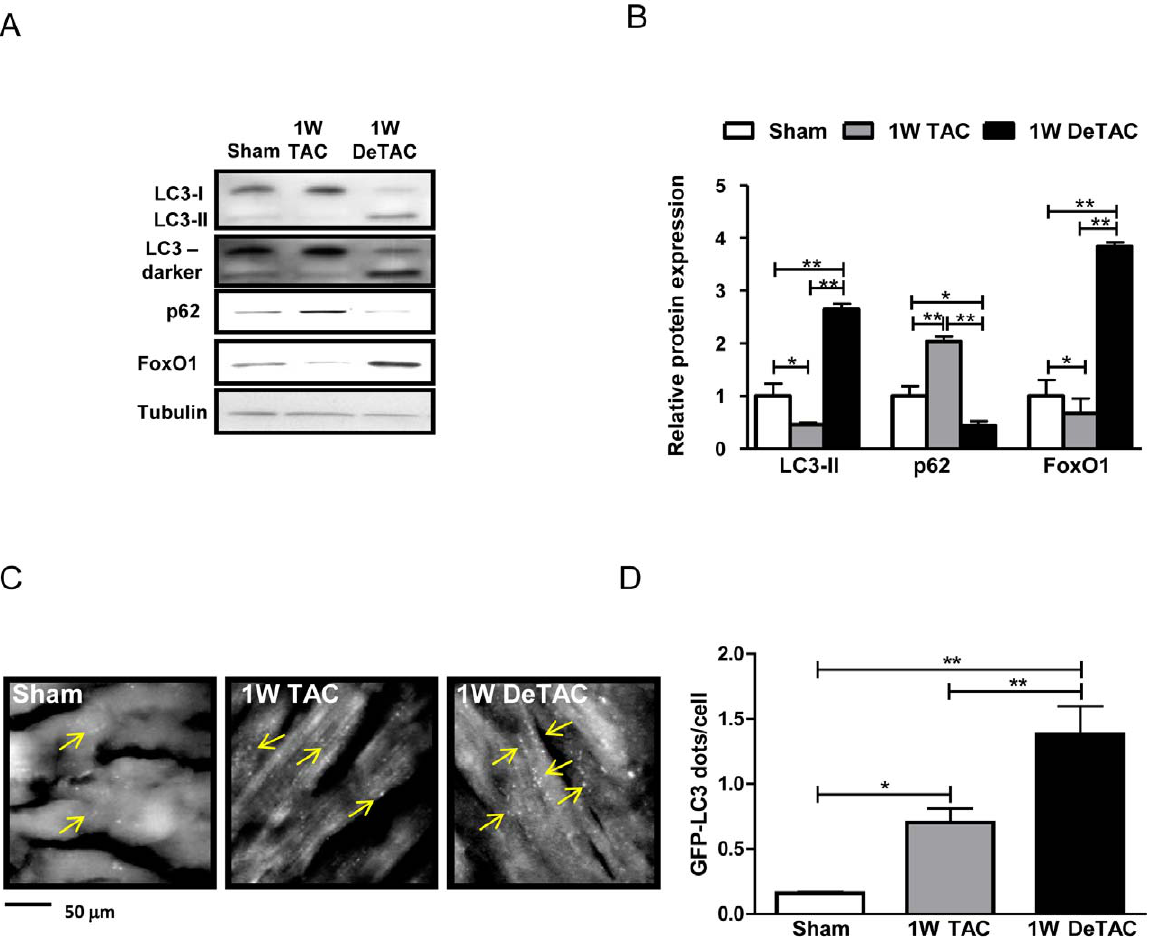
Figure 2. Autophagy and FoxO1 expression are upregulated during regression of cardiac hypertrophy. Control C57BL/6 and Tg-GFP- LC3 mice were subjected to sham, 1W TAC and 1W DeTAC surgeries. A) Representative immunoblots of autophagy markers and FoxO1 from mouse hearts. B) Densitometric analyses. C) Representative images of fluorescent LC3 puncta in hearts from Tg-GFP-LC3 mice. Arrows indicate LC3 puncta. D) Mean number of GFP-LC3 dots/cell. Data represent means from at least 3 mice each. * p , 0.05, ** p ,